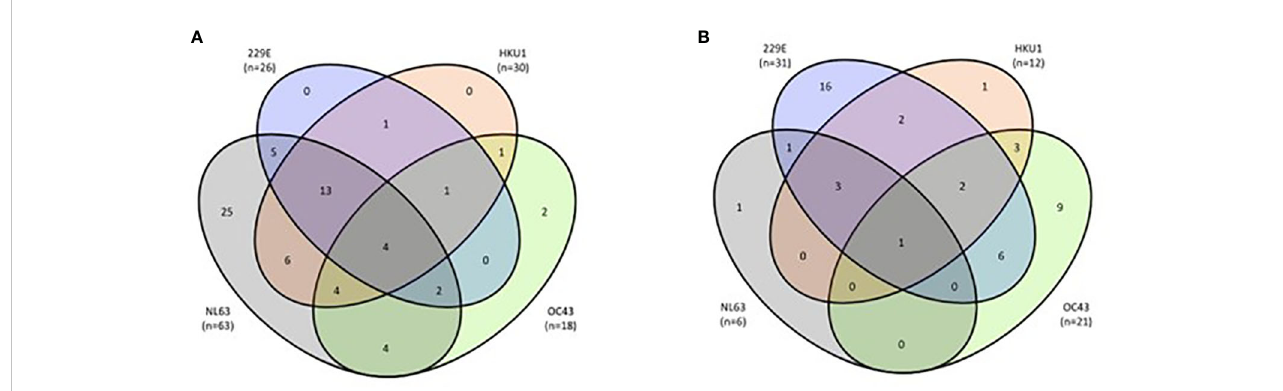
FIGURE 1 Coinfection frequency between the four HCoV. (A) Group 1 (n=94) asymptomatic patients (total infections: n=68; coinfections: n=41). (B) Group 2 (n=92): hospitalized patients (total infections: n=45 confections: n=18). Grey color indicates HCoV-NL63, purple color indicates HCoV-229E, orange color HCoV-HKU1 and green color HCoV-OC43 seropositivity,